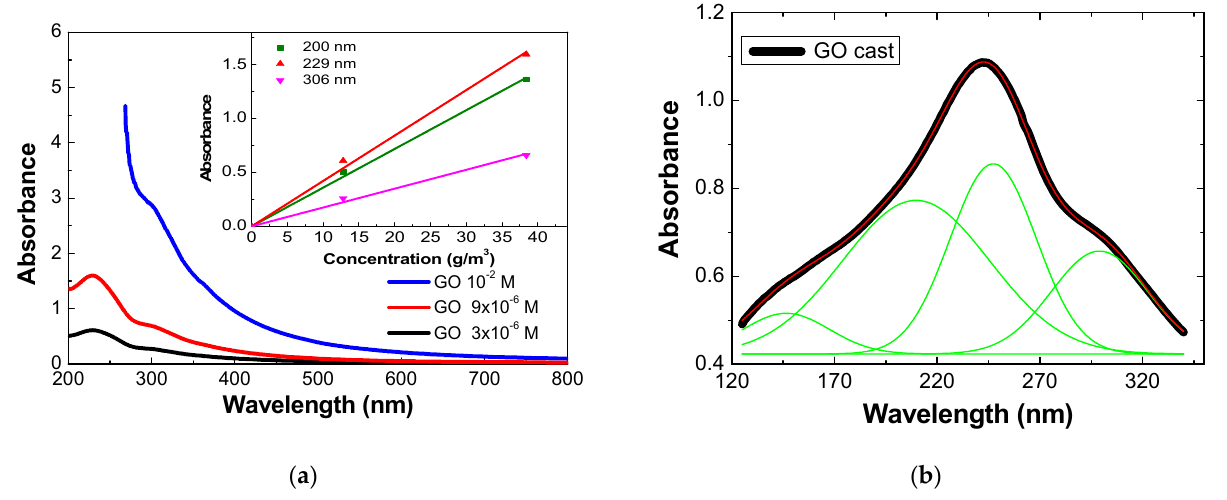
Figure 1. ( a ) UV-visible absorption spectra of aqueous GO solutions with concentrations of 3 × 10 -6 , 9 × 10 -6 M and 10 -2 M (for comparison). The inset shows the absorbance at different wavelengths as a function of the concentration of the GO aqueous solutions. ( b ) VUV absorption spectrum of a neat GO cast film deposited on a CaF 2 substrate. Green lines are the obtained fit with Gaussian curves, and the red curve is the sum curve of all the fits.